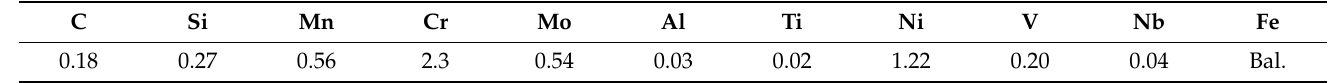
Table 2. The chemical composition of experimental steel (weight percent).